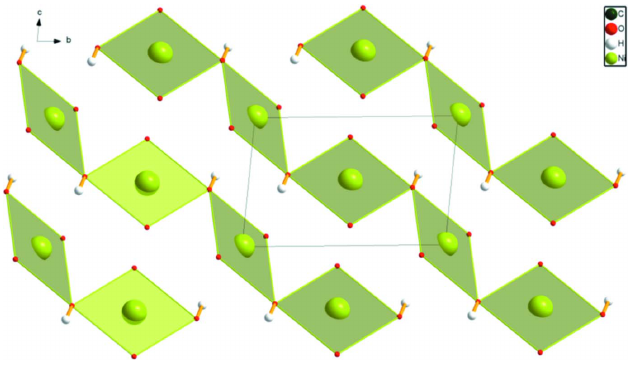
Figure 10 View of the discontinuous layers in Ni 2 (BPDC)(OH) 2 down the a- axis. Image generated using DIAMOND (Crystal Impact, 2022).